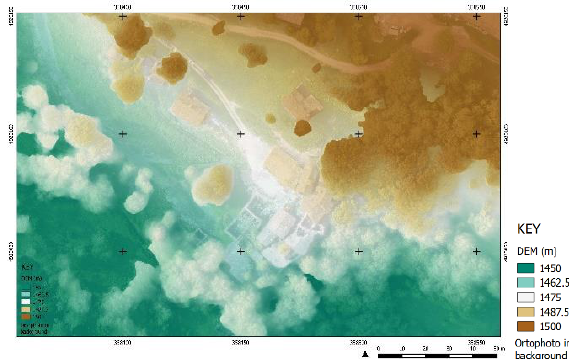
Figure10.Orthophoto (prev. column), a zoom in the center of the village above entire analyzed area center, and (here)